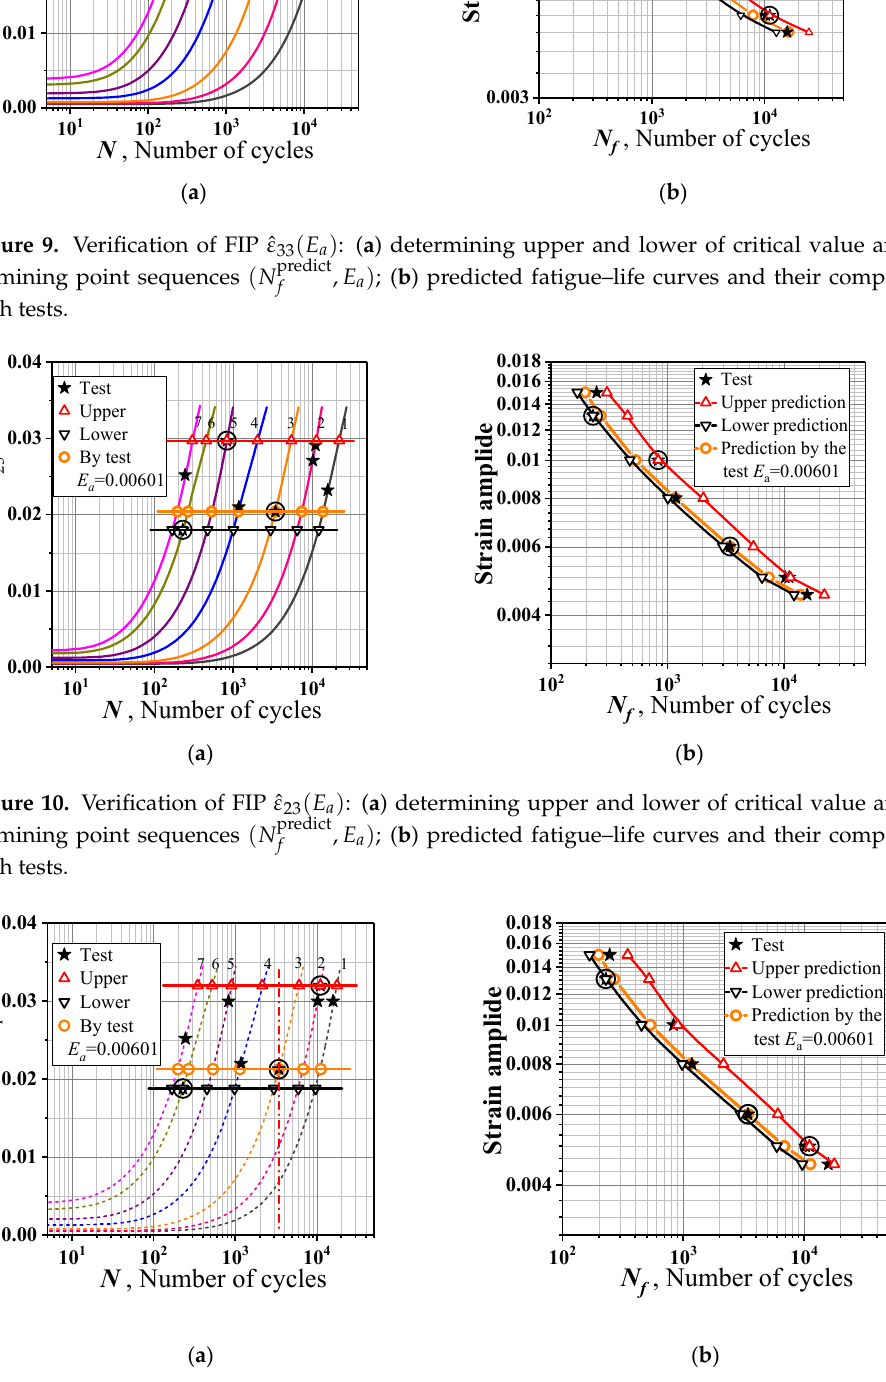
ˆ ( ) E ε : ( a ) determining upper and lower of critical value and de- Figure 11. Verification of FIP Figure 11. Verification of FIP ˆ ε eq ( E a ) : ( a ) determining upper and lower of critical value and deter- eq a